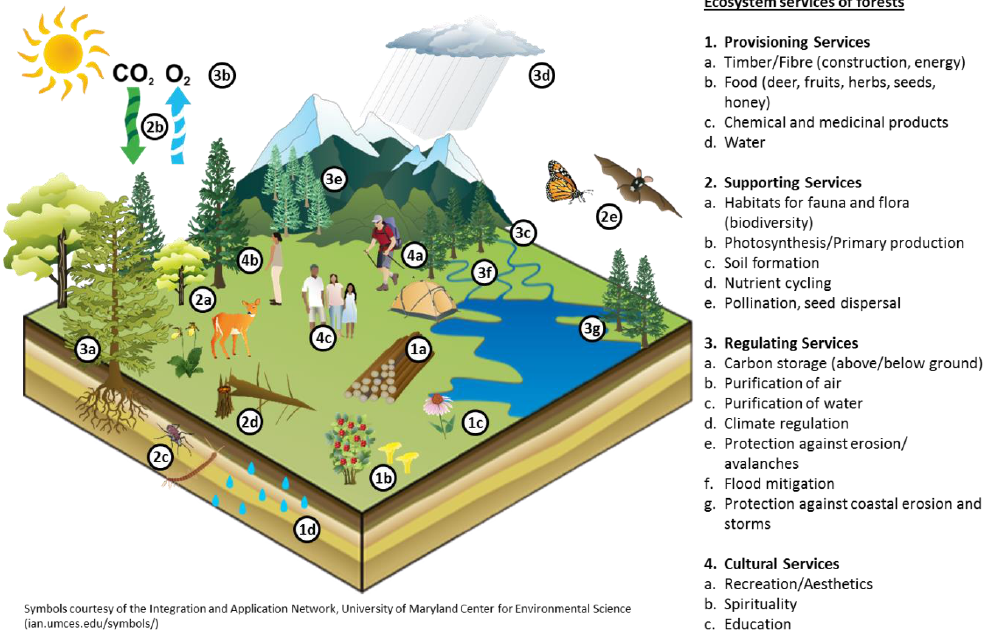
Figure 1. Ecosystem services of forests, subdivided into provisioning services, supporting services, regulating services, and cultural services.